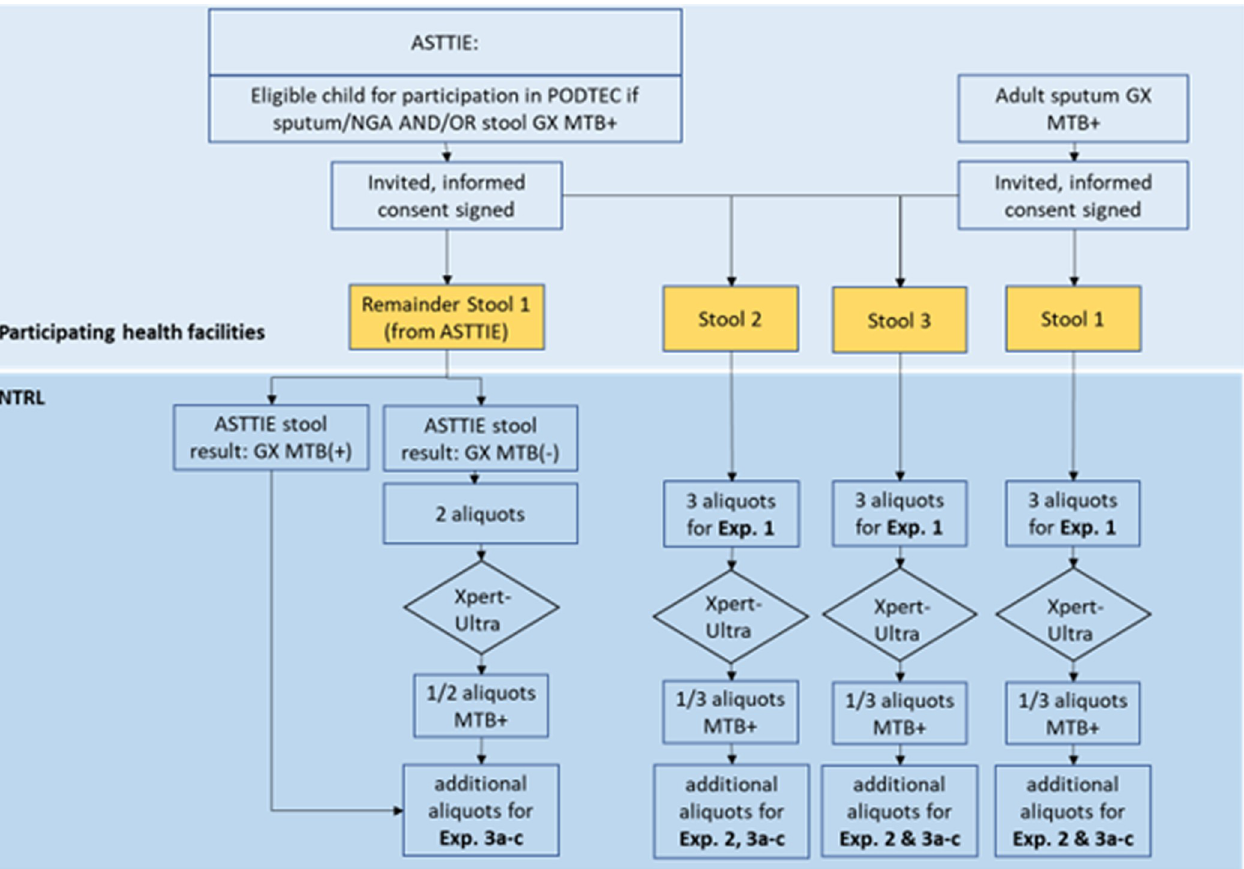
Fig 1. Study flow diagram representing steps from inclusion of adults and children to arrival of the stool samples at EPHI and their allocation to the different experiments. � Site of action is depicted with blue background boxes; and stool samples are in yellow boxes. Abbreviations used: ASTTIE; Alternatives to Sputum Testing for Tuberculosis in Indonesia and Ethiopia, PODTEC: Painless Optimized Diagnosis of TB in Ethiopian Children, NTRL: National TB Reference Laboratory, NGA: Naso-Gastric Aspiration, MTB: M . tuberculosis , GX; GeneXpert, Exp.: Experiment.